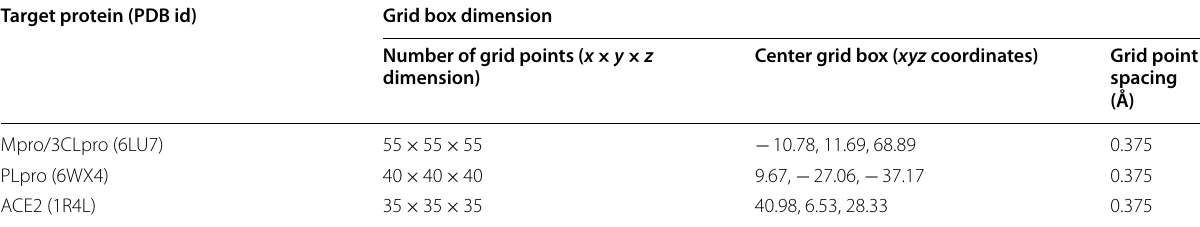
Table 2 Grid box coordinates used in AutoDock Vina for molecular docking studies against Mpro/3CLpro, PLpro and ACE2 of COVID-19 Target protein (PDB